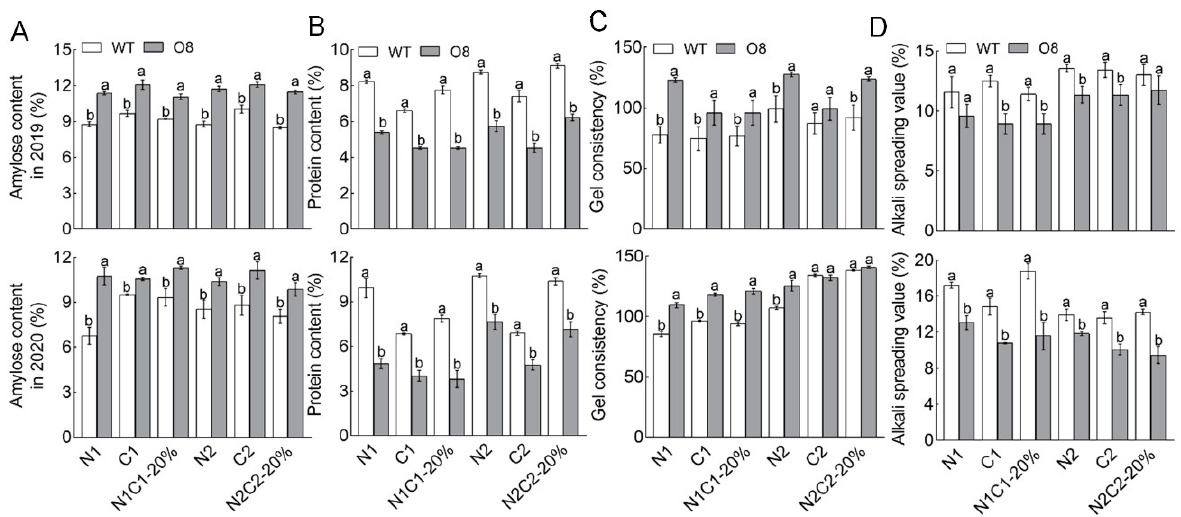
Figure 4. Cooking and eating quality of overexpression OsNRT2.3b line and wild type. Amylose content ( A ), protein content ( B ), gel consistency ( C ), and alkali spreading value ( D ) of overexpression OsNRT2.3b line (O8) and wild type (WT) under different fertilizer treatment conditions in two years, 2019 and 2020. N1: treatment with 90 kg/ha nitrogen fertilizer. C1: treatment with 90 kg/ha carbon fertilizer. N1C1-20%: 20% carbon fertilizer instead of nitrogen fertilizer (90 kg/ha). N2: treatment with 270 kg/ha nitrogen fertilizer. C2: treatment with 270 kg/ha carbon fertilizer. N2C2-20%: 20% carbon fertilizer instead of nitrogen fertilizer (270 kg/ha). Significant differences between O8 and WT are indicated by different letters ( p < 0.05).